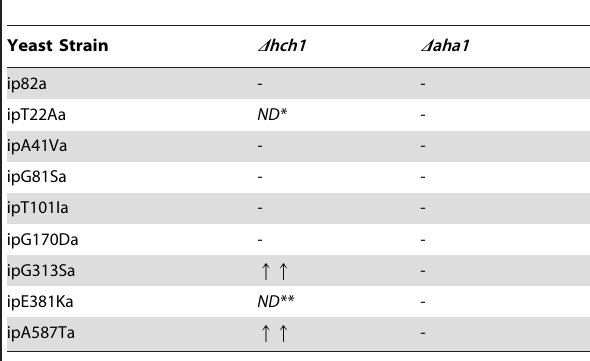
Table 2. Effect of HCH1 or AHA1 deletion on yeast growth.